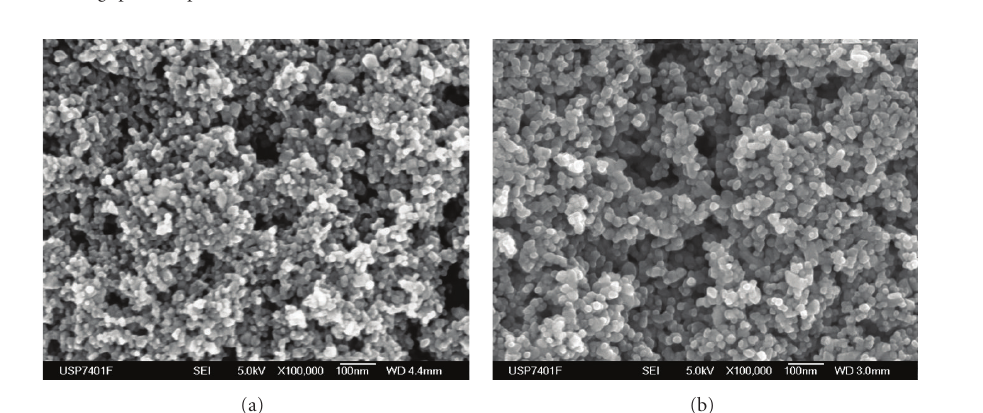
Figure 1: Scanning electron micrographs of TiO 2 nanoparticles obtained by acid (a) or alkaline (b) routes on